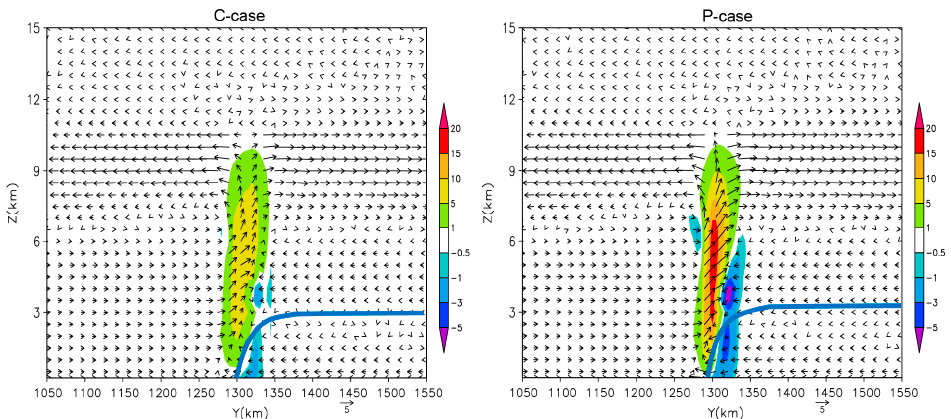
Figure 11. Vertical cross sections of zonal-mean Latent Heating (The warm color shadings show heating greater than 1 K h − 1 ; the cold color shadings show cooling less than − 0.5 K h − 1 ) and cross-front wind perturbation vectors ( v (cid:48) , w ) at t = 21 h. The blue thick line indicates the front. Only a 500 km × 15 km of the domain is presented. The left panel shows C-case, the right panel shows P-case.